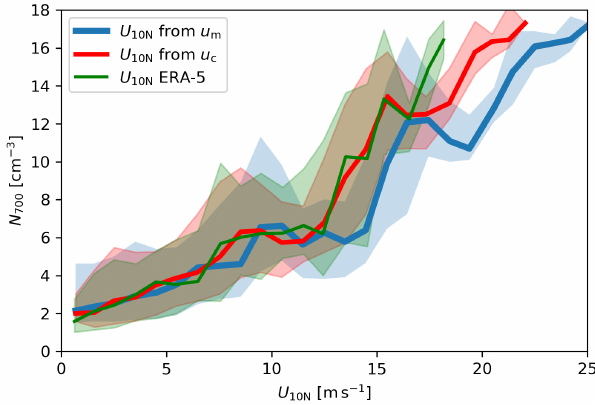
Figure 13. The concentration of particles with an aerodynamic di- ameter D a > 700nm from legs 1, 2, and 3 as a function of u 10N . The lines show the median, and the shaded area shows the IQR cal- culated over 1ms − 1 wind speed bins. Only data points are included, where contamination from the exhaust stack emissions could be ex- cluded, the calculated air mass back trajectories were over sea for at least 24h, and the distance to the nearest landmass was more than